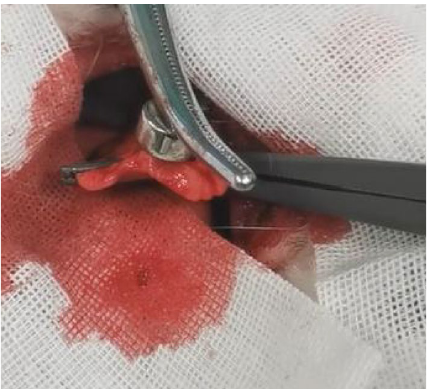
Figure 7. Localization effect under applied magnetic